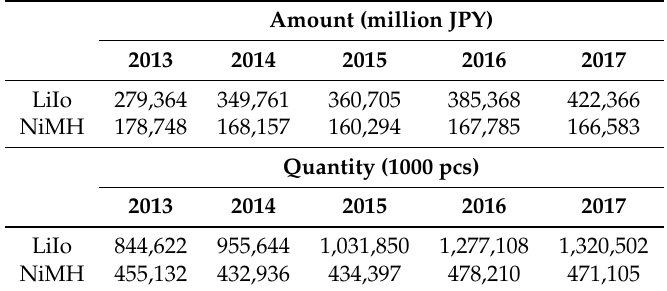
Table 1. Rechargeable battery sale statistics in Japan